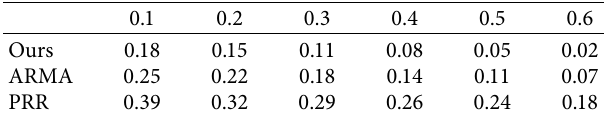
Figure 3: Energy